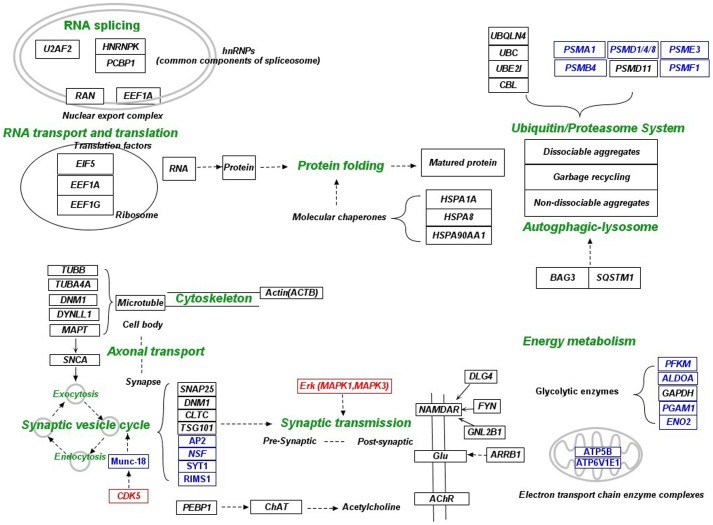
Mechanistic illustration of the adaptation strategy reflected in the hub network via manual integration of literature and KEGG pathways (part 1).The “healthy” neurons respond to the AD-specific microenvironment through the reduction of neuronal and synaptic activities. Relevant functional categories for neuronal and synaptic activities include energy metabolism, RNA splicing, RNA transport and translation, cellular recycling system, cytoskeleton (axonal transport), pre- and post- synaptic activities. Hub genes are indicated by black color. Closely related non-hub genes in the perturbed subnetwork are indicated by blue color. Transcription factors and kinases whose targets or substrates were enriched in the subnetwork are indicated with red color. Cellular functions are indicated by green color.